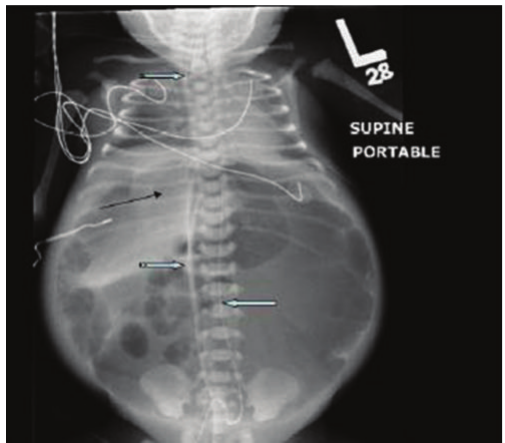
Figure 2: A baby gram X-ray showing a severely distended abdomen with free intraperitoneal air in front of liver (black arrow) and umbilical artery catheter (right striped block arrow) and umbilical vein catheter (left block arrow) in situ. An endotracheal tube (notched block arrow) is noted in situ and both diaphragms are significantly elevated.